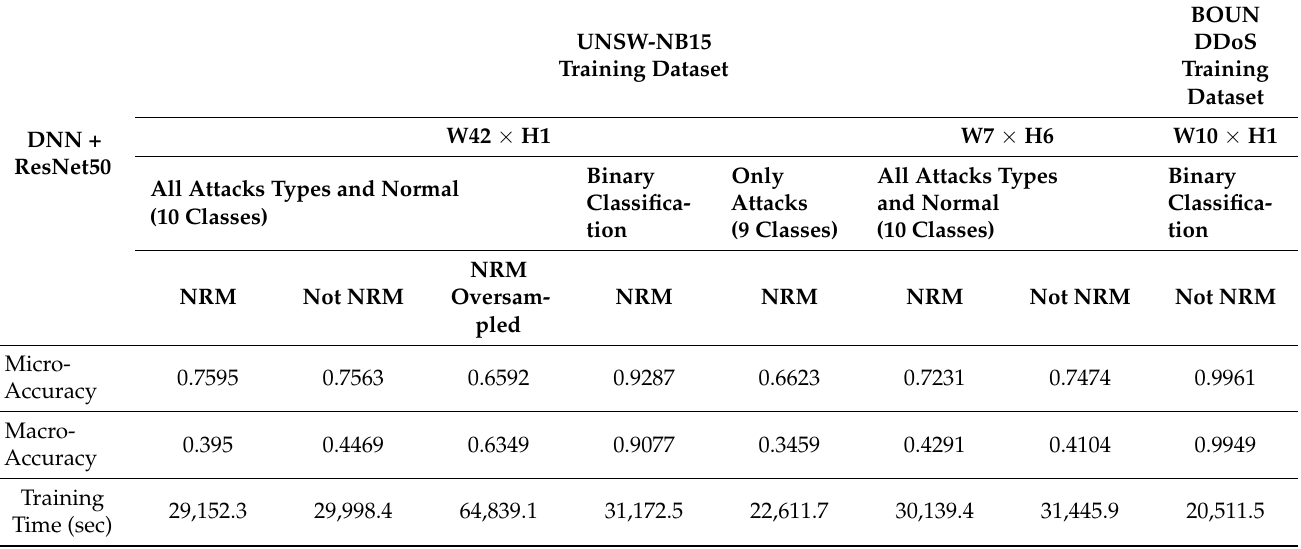
Table 10. Summary of Visual Studio 2019 ML.NET training classification